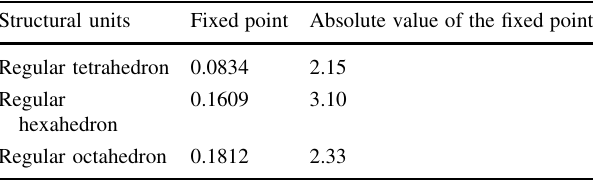
Fig. 9 Solution of the fixed points in the granule-centered regular hexahedron and regular octahedron Table 2 Absolute values of the slopes of fixed points in different granule-centered structures Structural units Fixed point Absolute value of the fixed point Regular tetrahedron